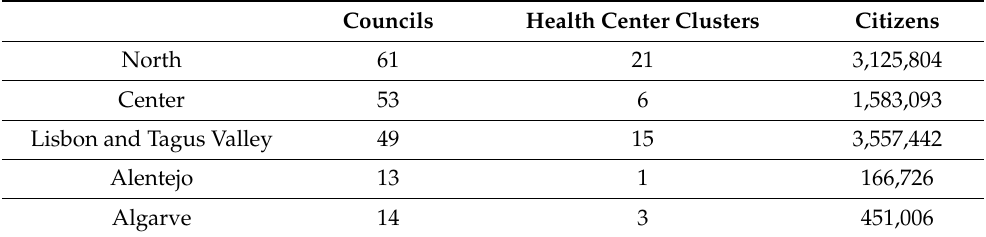
Table 4. Entities participating in the health decentralization process [29–31].